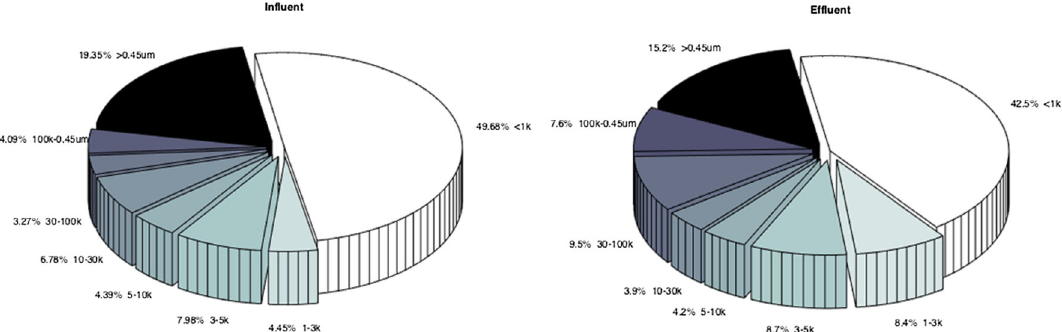
Fig. 4 COD distribution proportion in biological influent and